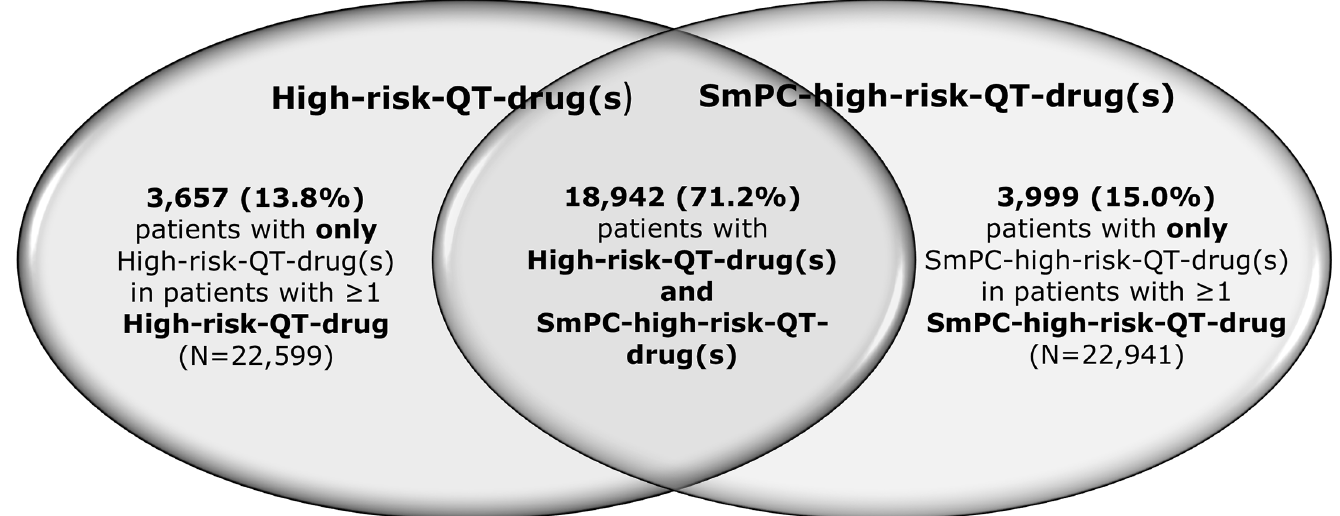
Fig 4. Number of patients identified by one or both QT-classifications. The figure presents the overlap of the two patients groups with at least one drug of the High-risk-QT-drug-group or the SmPC-high-risk-QT-drug-group. The intersection in the middle shows the proportion of patients with at least one QT-drug included in both groups (71.2%; N = 18,942). 13.8% (N = 3,657) of the patients with at least one High-risk-drug received no SmPC-high-risk- QT-drug and 15.0% (N = 3,999) of the patients with at least one SmPC-high-risk-QT-drug were without prescription of a